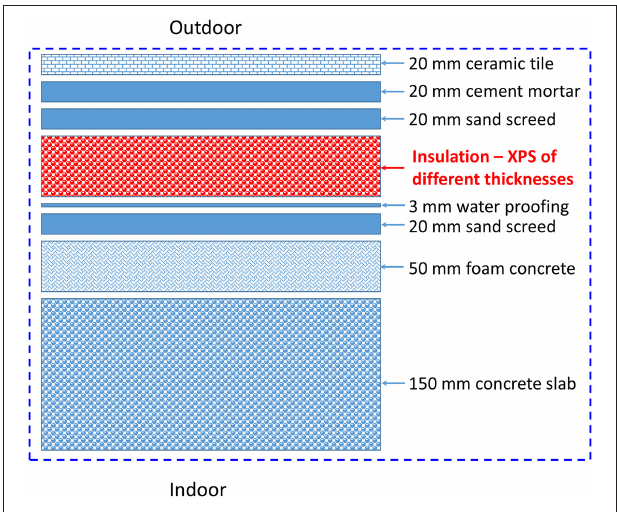
FIGURE 1 | Schematics of roof with different insulation